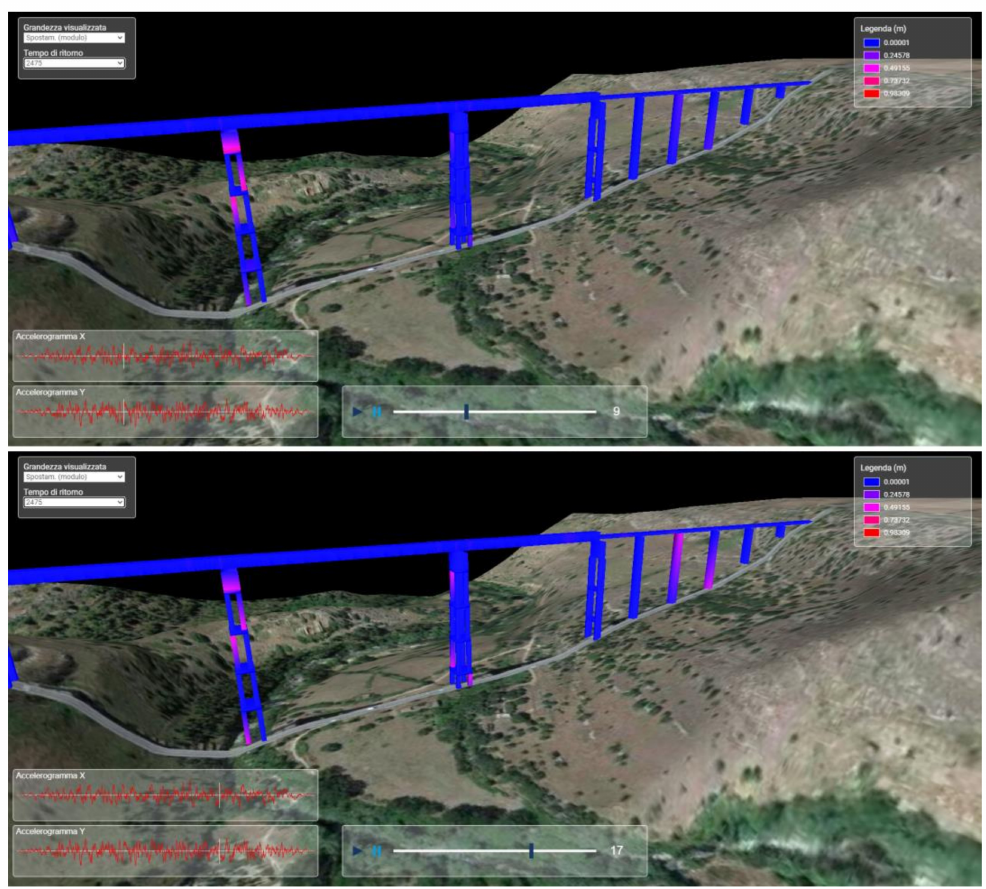
Figure 30. Differences in coloration in different